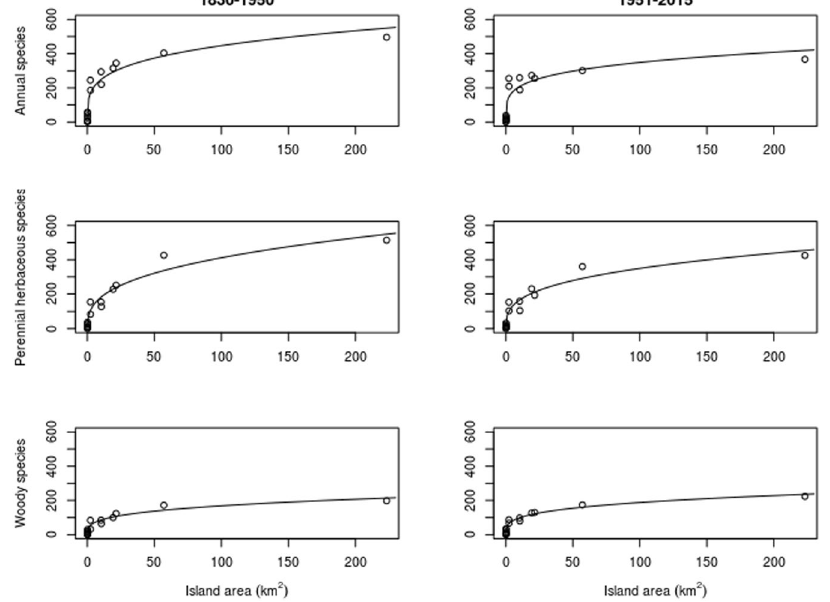
Figure 2. Island Species-Area Relationship, based on the Arrhenius model ( S = C·A z ), calculated for plant species richness of the islands of the Tuscan Archipelago for the first period (1830–1950, left panels) and for the second period (1951–2015, right panels) for annual herbaceous (upper panels), perennial herbaceous (middle panels), and woody (lower panels) species,